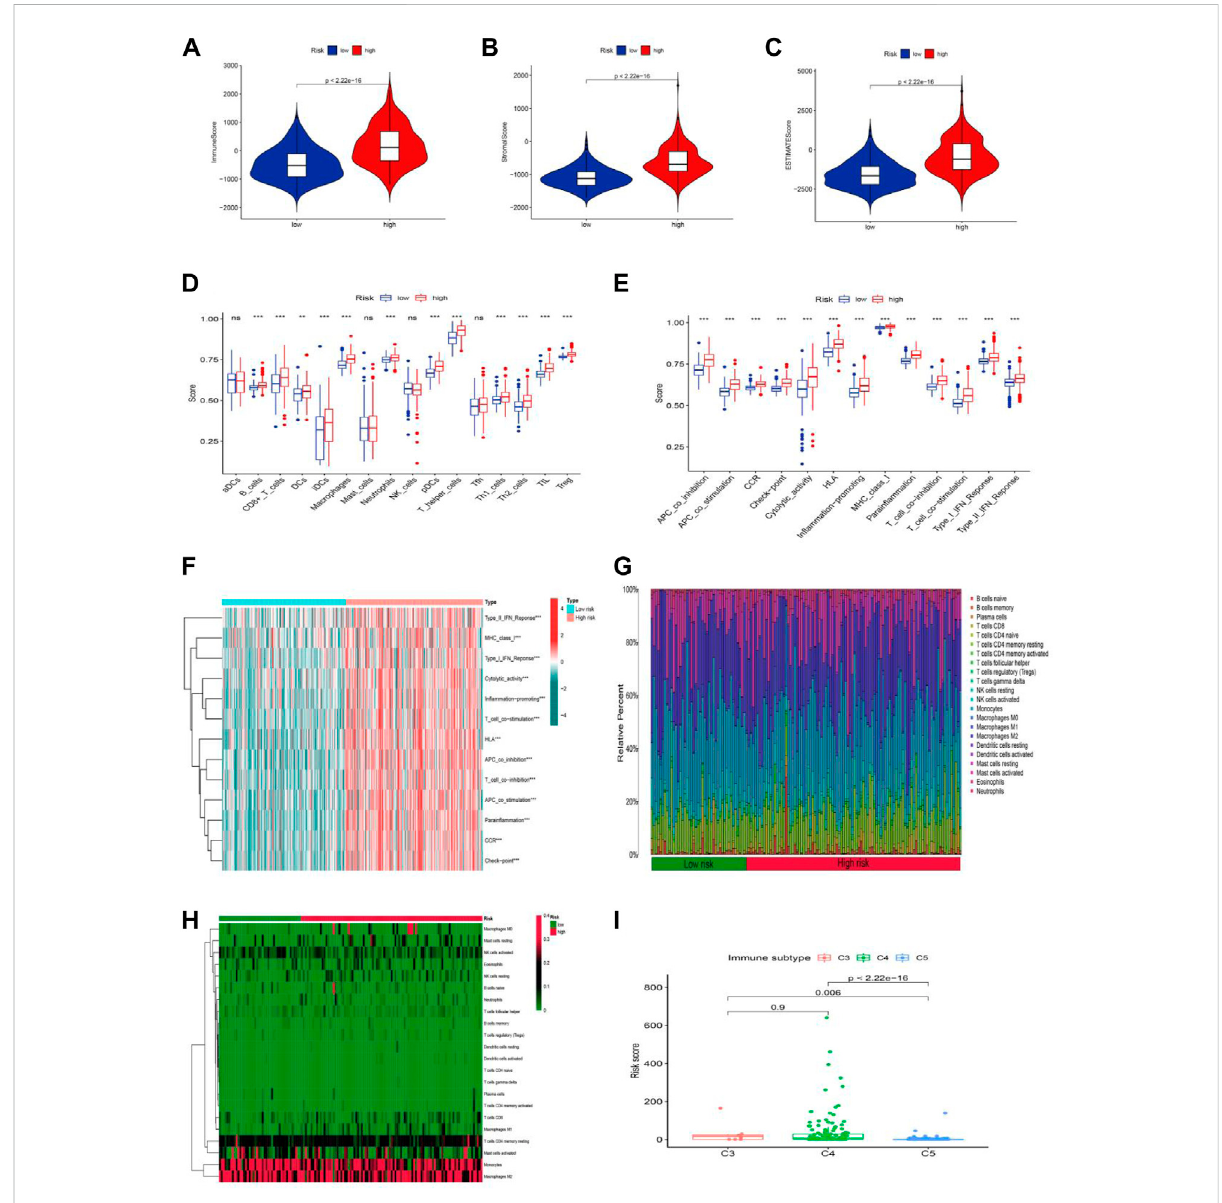
FIGURE 8 Strati fi cationAnalysisofthecuproptosis-relatedlncRNAprognosticriskscoreinimmunefeatures. (A – C) TheassessmentofTMErelatedscores between high- and low-risk groups. (D – F) The score of immune cells comparing high-risk and low-risk groups by ssGSEA Score. (G,H) Heatmap of 22 tumor-in fi ltrating immune cell types in low- and high-risk groups. (I) LGG patients with different immune subtypes.